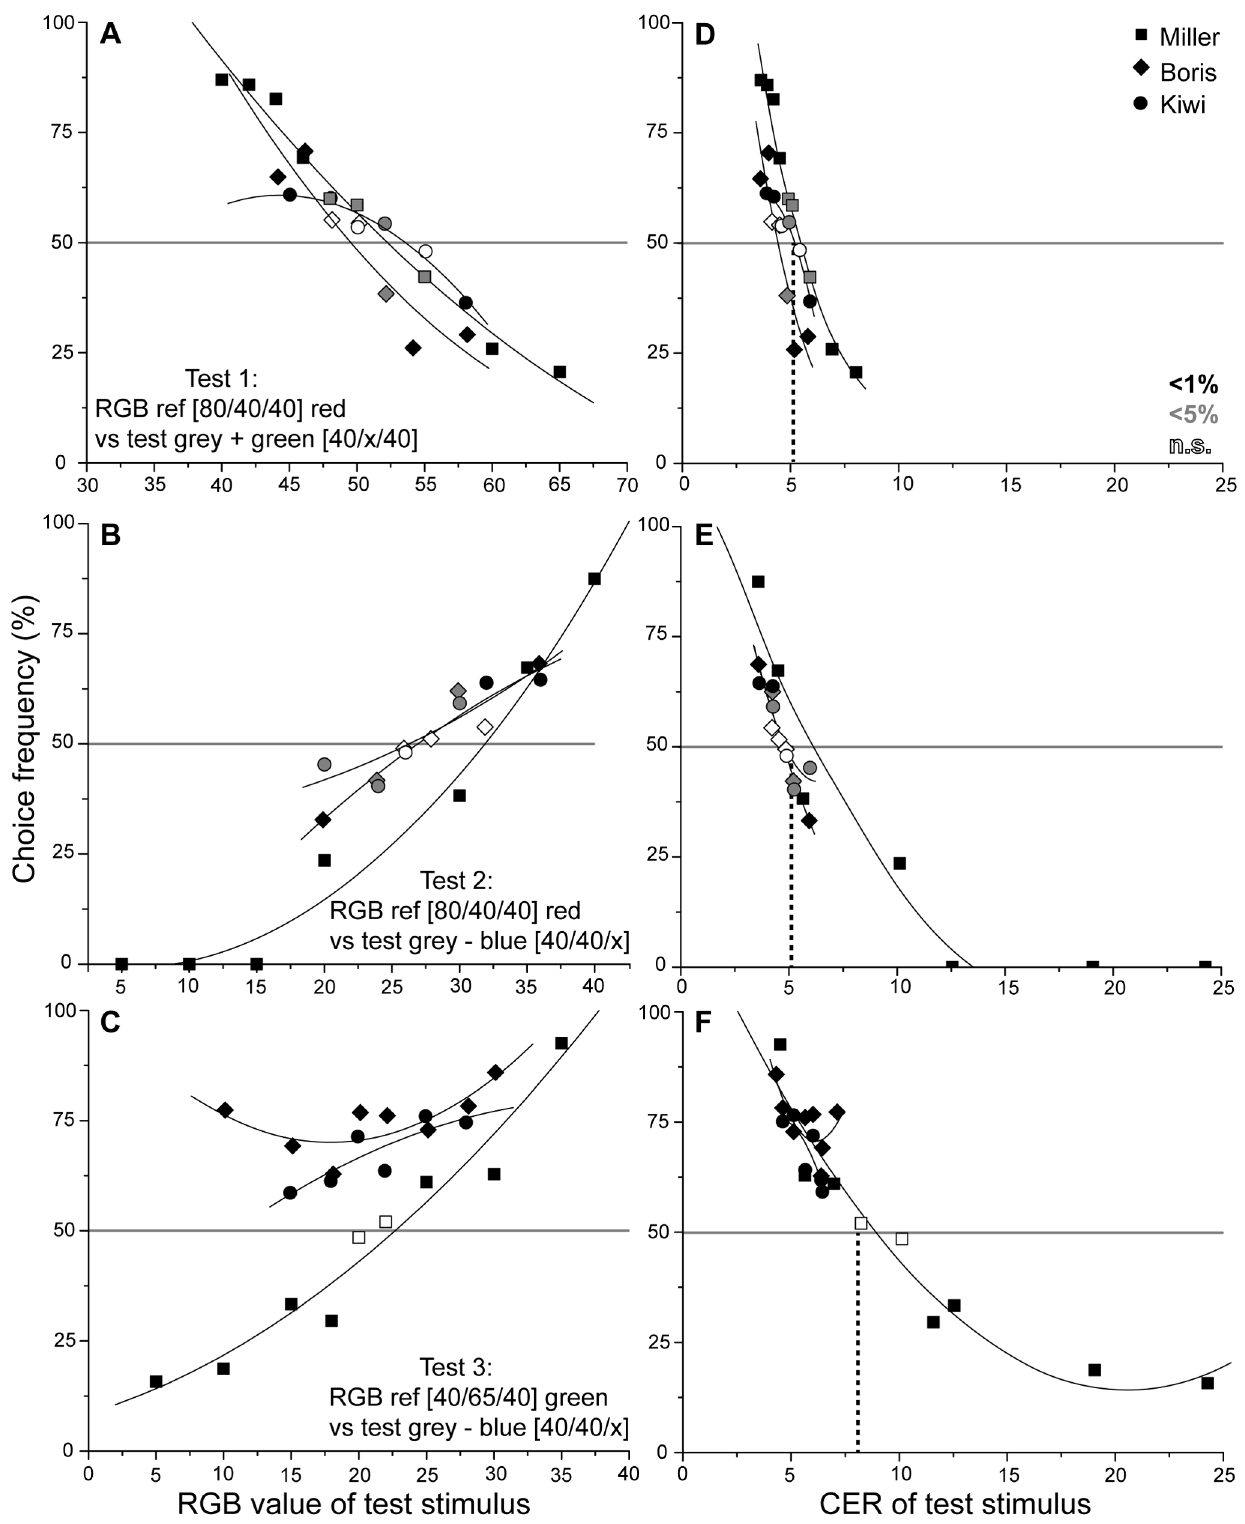
Figure 3. Colour-mixing experiments yielded Confusion Points for various RGB colour combinations. Choice frequencies of the reference stimulus (red in Test 1, A and D; red in Test 2, B and E; green in Test 3, C and F) are presented as a function of a gradually varied colour composition of a test stimulus (green in Test 1, A and D; blue in Test 2, B and E; blue in Test 3, C and F). (A–C) The animals’ stimulus preference reversed, intersecting the 50% mark which was defined as the Confusion Point. (D–E) Converted into excitation ratios of M/S-cones, the data reveal a match between CER for both test and reference stimulus at the Confusion Point (dashed vertical lines).